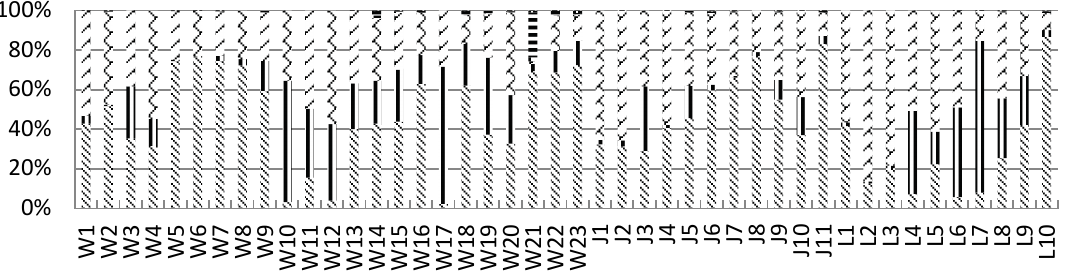
Fig. 2 Land-use distribution at the sub-basin